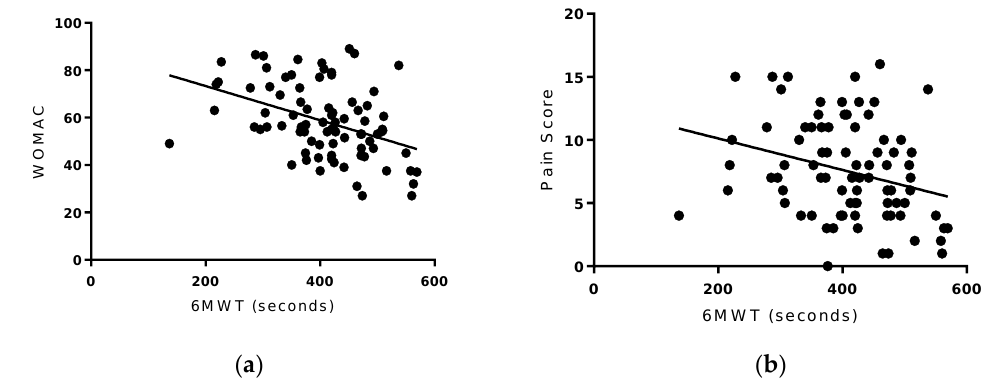
Figure 4. Right panel ( a ): WOMAC score vs. 6-MWT. While WOMAC scores decreased, distance walked during the 6-MWT increased ( r = − 0.413, p < 0.001). Left panel ( b ): pain score vs. 6-MWT. As pain scores decreased, distance walked during the 6-MWT increased ( r = − 0.222, p = 0.010).